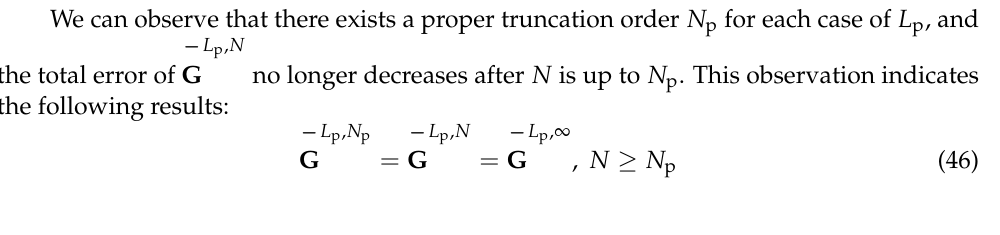
L p , N ¯ , L N G Figure 5. Error of G with increasing truncation order N for three cases of L p when the medium Figure 5. Error of p with increasing truncation order N for three cases of is dium is isotropic.